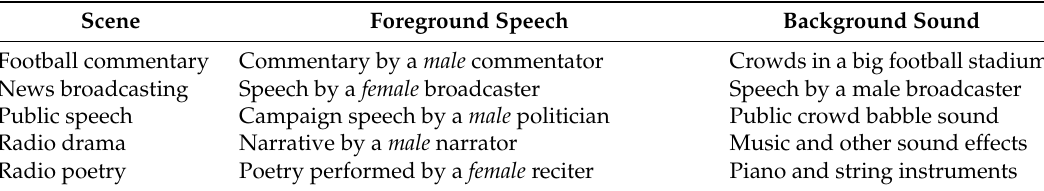
Table 2. Foreground speech and background sound in the five audio scenes presented in Expt.